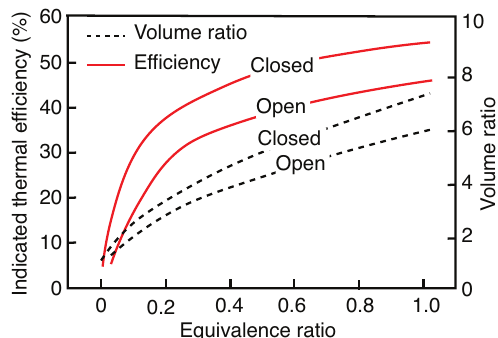
Figure 6. Efficiency and volume ratios for the reference actuator for open and closed cycles.